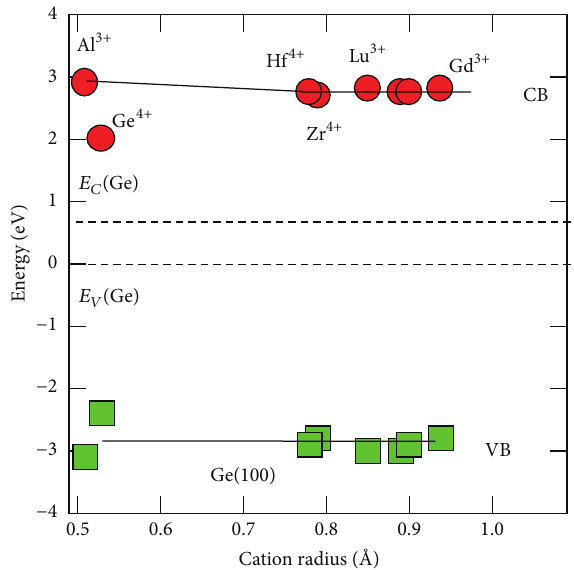
Figure 18: Energies of the VB top and CB bottom in different oxides as a function of cation radius referenced to the band edges for Ge crystal as inferred from the IPE experiments. The top of the Ge VB is at 𝛿𝐸 𝑉 = 0.4 eV above the silicon VB as measured relative to the common a-Al 2 O 3 CB bottom reference